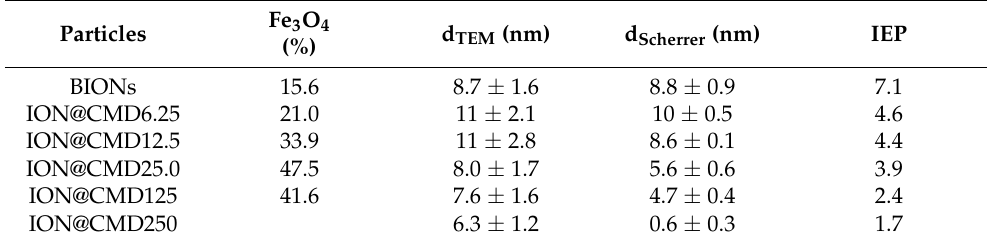
Table 1. Magnetite contents of BIONs and ION@CMD6.25 to 125, determined by comparing the magnetite peak area (660 cm − 1 ) and maghemite peak area (710 cm − 1 ). For ION@CMD250, no iron oxide peak could be measured due to the thick CMD coating. The mean diameter was determined via TEM and Scherrer equation and